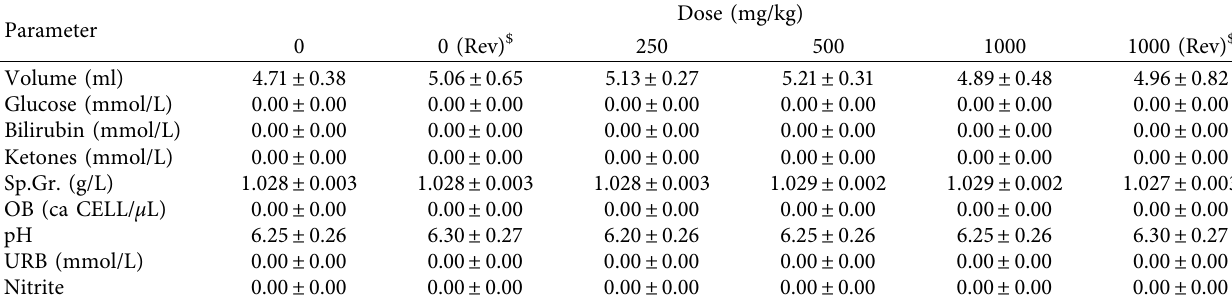
Table 8: Effect of GutGard on urine parameters of female rats during 90D oral toxicity study.